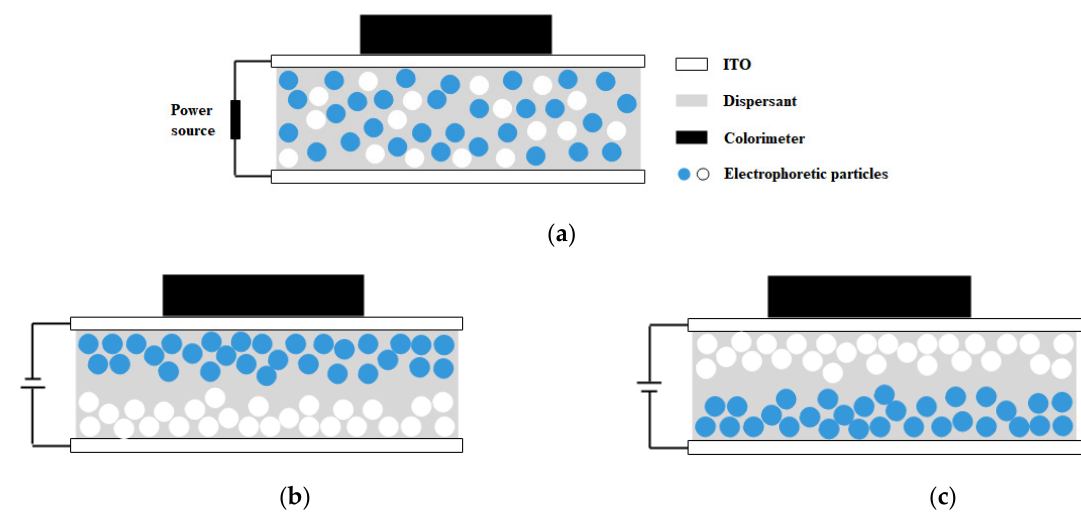
Figure 2. Schematic diagram of a blue and white dual-color electrophoretic display (EPD) cell ( a ). Schematic diagram of the blue and white dual-color EPD cell with positive charges on the lower plate ( b ). Schematic diagram of the blue and white dual-color EPD cell with positive charges on the upper plate ( c ).